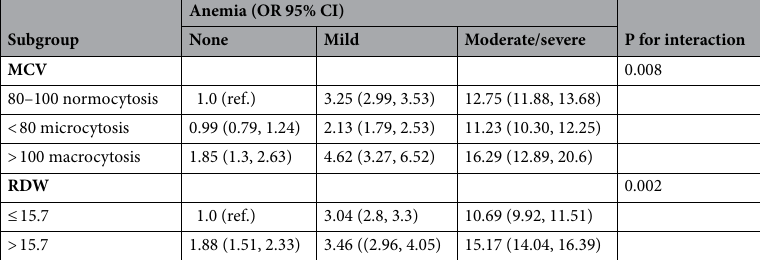
indicates that the model had good calibration (Fig. 3B,C). The calibration plot revealed an adequate model fit for predicting the risk of transfusion. The nomogram score system for transfusion risk prediction and clinical utility.